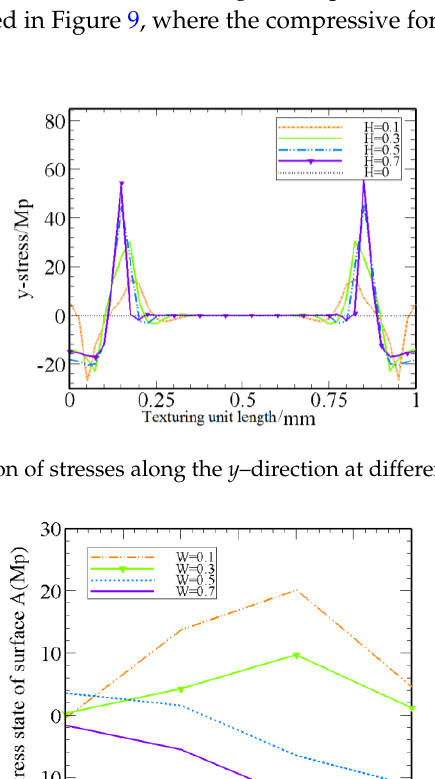
Figure 10. Distribution of stresses along the x –direction at different texturing depths and W = 0.1.